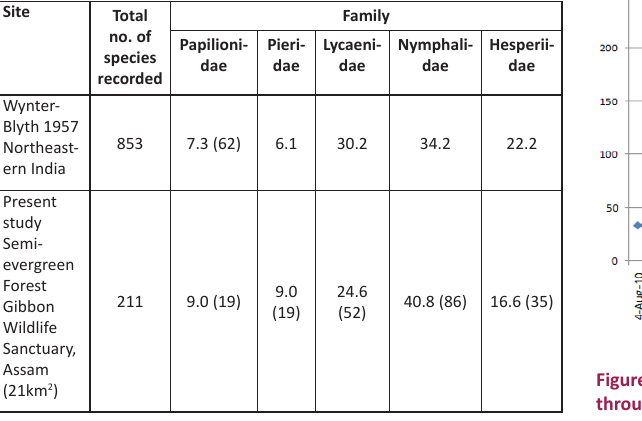
Table 1. Comparison of the proportion of butterfly families recorded from Gibbon WS with northeastern India